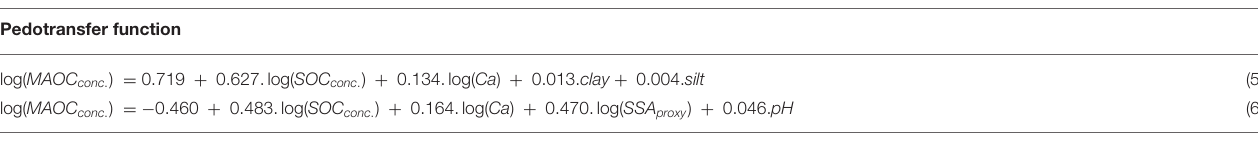
TABLE 2 | Pedotransfer functions produced from best-fit stepwise multiple regression with AIC models using either soil texture variables (% clay and silt; Equation 5) or SSA proxy (Equation